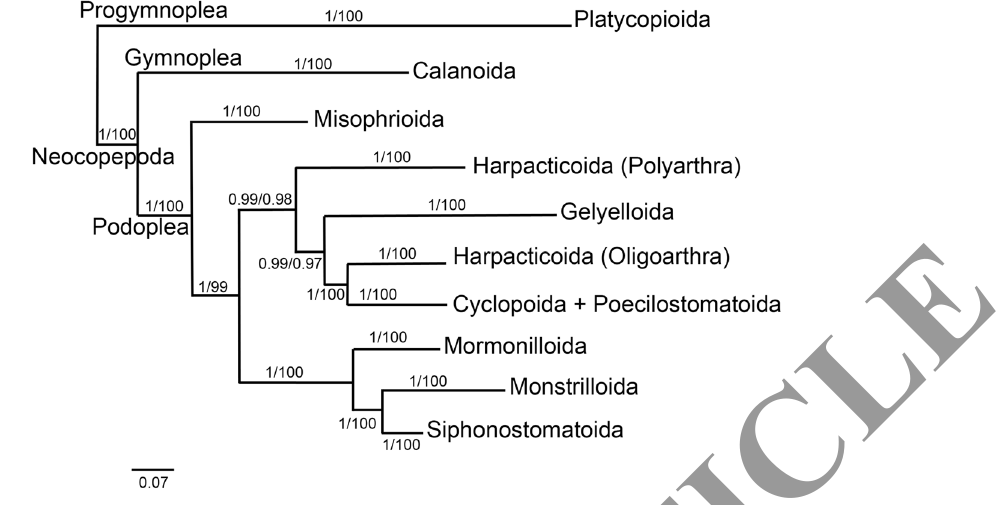
Figure 2. Order-level phylogram of 10 copepod orders. Phylogenetic relationship of 210 copepod species (collapsed to order level) based on Maximum Likelihood and Bayesian analysis of 18S and 28S rRNA, COI mtDNA and H3 histone protein. Nodal support is indicated by posterior probabilities and bootstrap values. Scale bar, nucleotide changes per